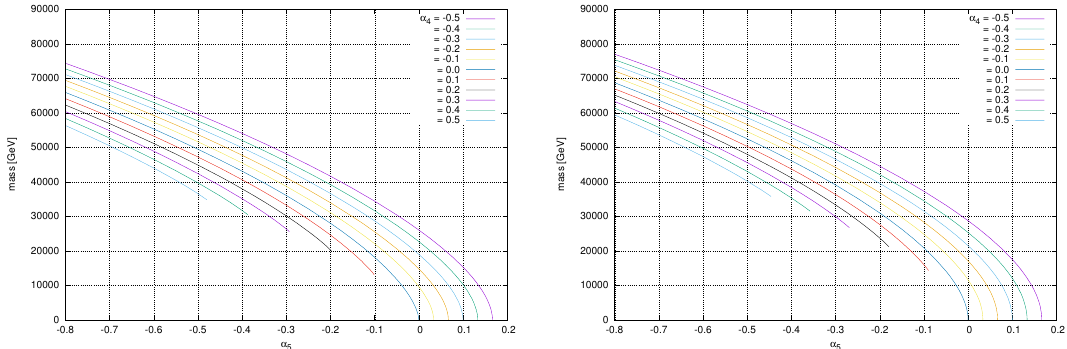
Figure 5 . Mass of the EW-Skyrmion as functions of (cid:11) 5 for various choice of (cid:11) 4 for the cases of ( a; b; c ) = (0 : 8 ; 1 ; 0) (left panel) and ( a; b; c ) = (1 : 2 ; 1 ; 0) (right panel).